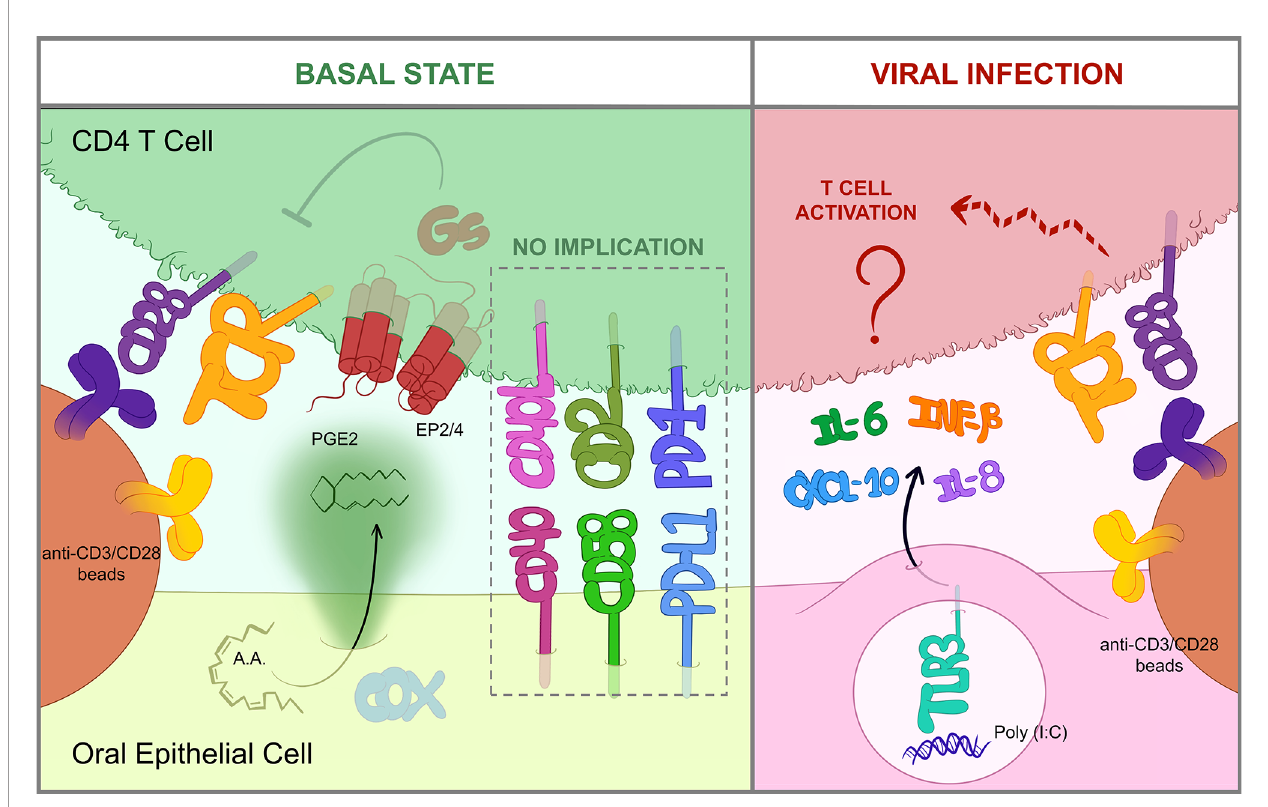
FIGURE 6 | OEC-mediated immunomodulation of T cells. Graphical summary of the most relevant fi ndings obtained in this study. In a basal state (left), OECs constitutively suppress T cells through the action of PGE2, which is produced by COX enzymes from arachidonic acid (AA) and then sensed by EP2/EP4 receptors in the T cell. EP2/EP4 signaling occur through Gs-proteins and eventually blocks TCR signaling, thus hindering activation by anti-CD3/CD28 antibodies (36). Cell-to- cell contacts including CD40/CD40L, CD58/CD2 or PD-L1/PD-1 are not involved in OEC-derived inhibition. Contrarily, when OECs are exposed to viral insults like poly(I:C), a dsRNA mimic and TLR3-inducer, they express IL-6, IL-8, IFNB1 and CXCL10 and relieve CD4 T cell suppression by an unknown mechanism